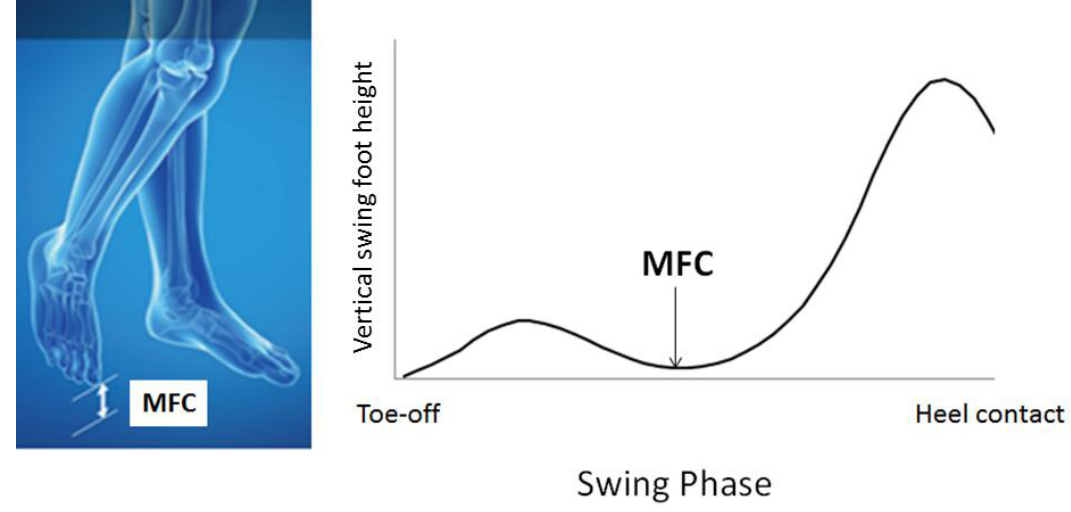
Figure 1. Minimum Foot Clearance (MFC).